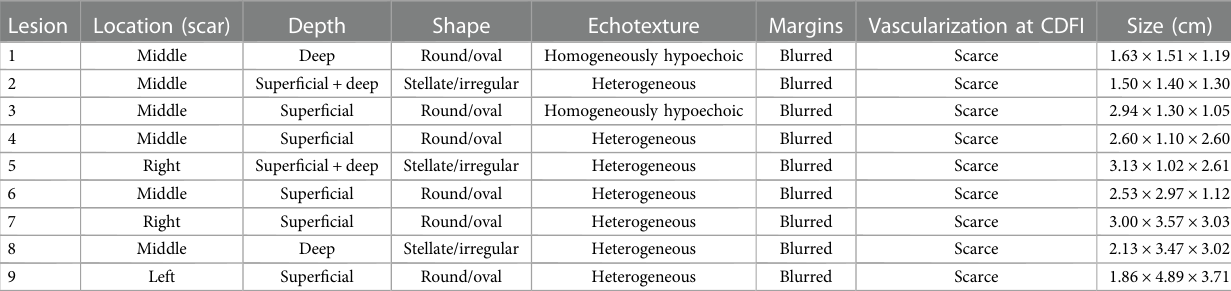
TABLE 3 Baseline characteristics of the AWE lesions.